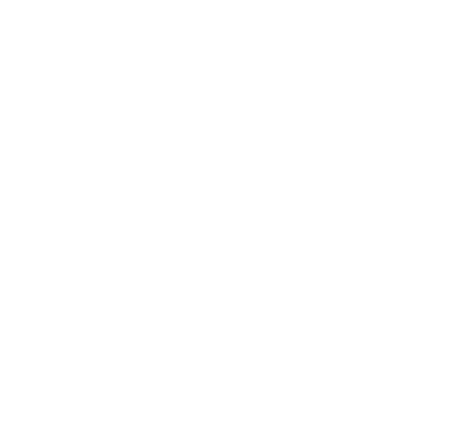
Figure 5. Local reloading of the damage model: the letters a , d , e are points on the curve of the partial reload cycle).